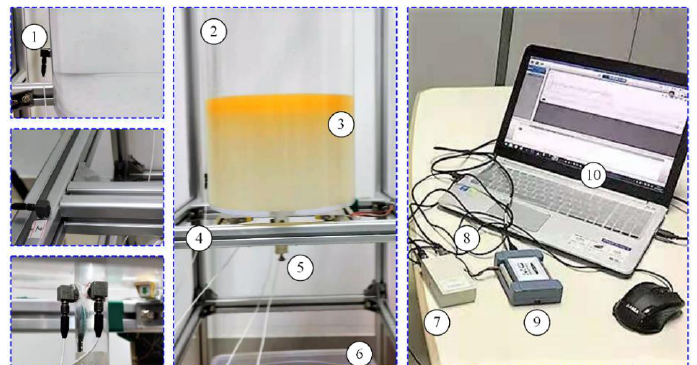
Figure 9. Vibration detection experiment platform of the multiphase vortex. 1 — Vibration sensor, 2 — Transparent cylindrical container, 3 — Two-phase fluid medium, 4 — Aluminum test bench, 5 — Adjustable throttle, 6 — Rectangular overflow container, 7 — Constant current adapter, 8 — Dual core cable, 9 — Data acquisition card, 10 — PC control system.